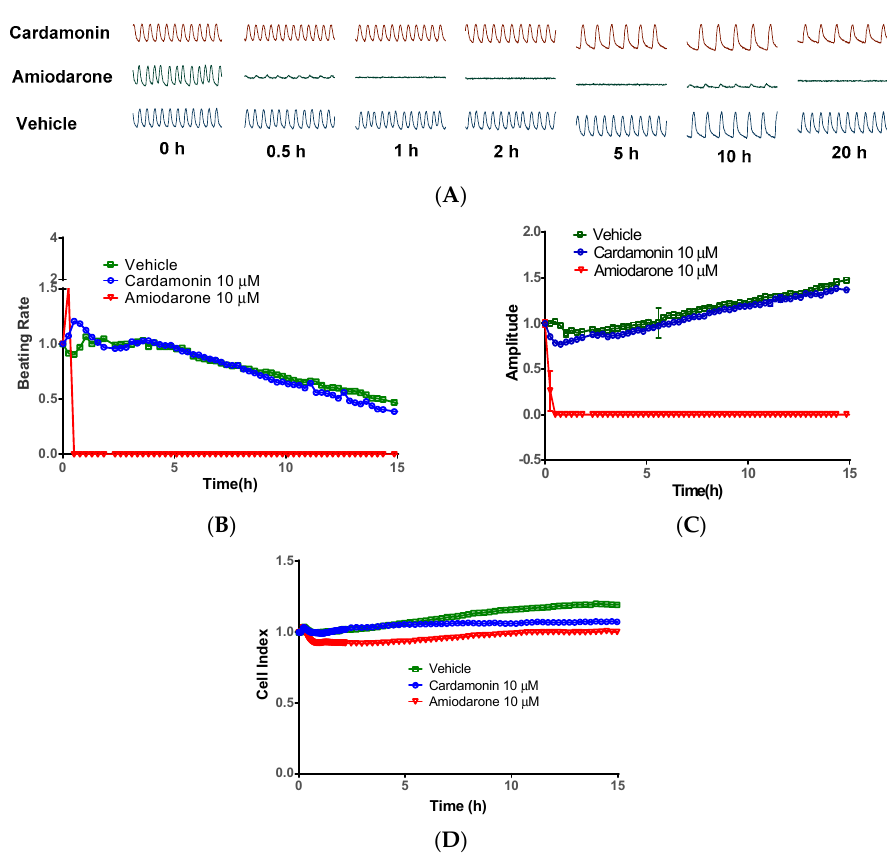
Figure 7. Cardiotoxicity evaluation of cardamonin on rat neonatal cardiomyocytes (CMs). ( A ) Contraction pattern of neonatal rat CMs in the presence or absence of cardamonin (10 μ M); ( B ) real-time beating rate analysis of CM cells with test compound; ( C ) normalized amplitude analysis of CMs in the presence of cardamonin or amiodarone; and ( D ) real-time analysis of CMs’ cell index with cardamonin or amiodarone. The CMs cells incubated with vehicle was used as negative control. Data is a representative of three independent experiments.